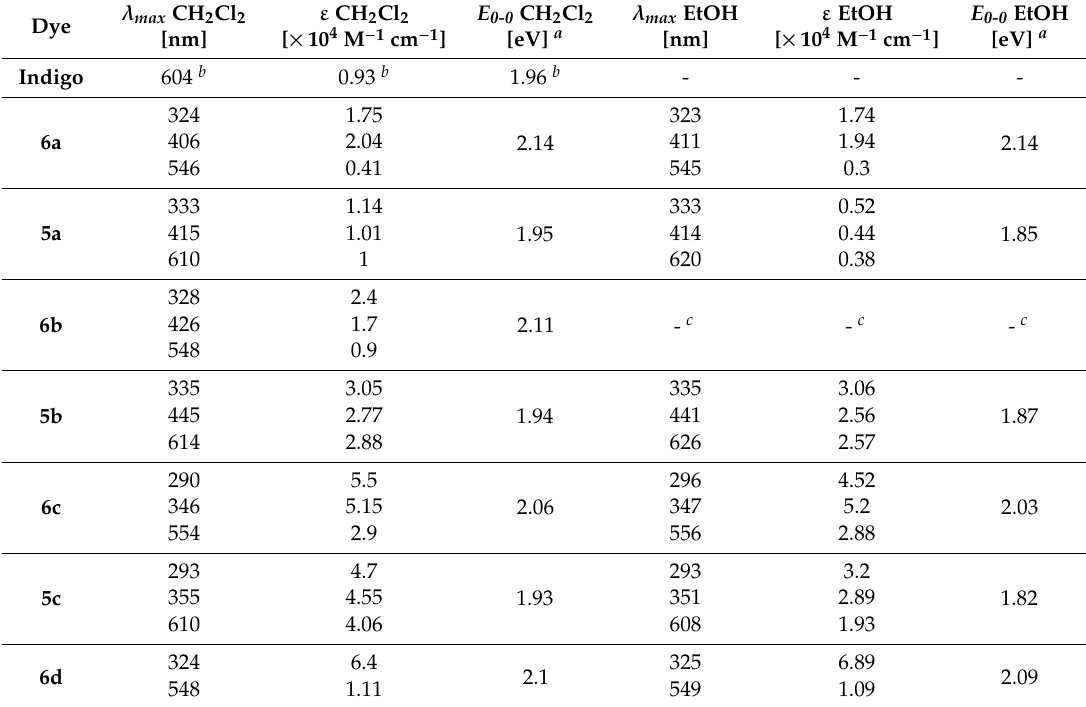
Table 2. Optical properties of dyes 5a – d and 6a – c compared with those of parent indigo compound. Dye